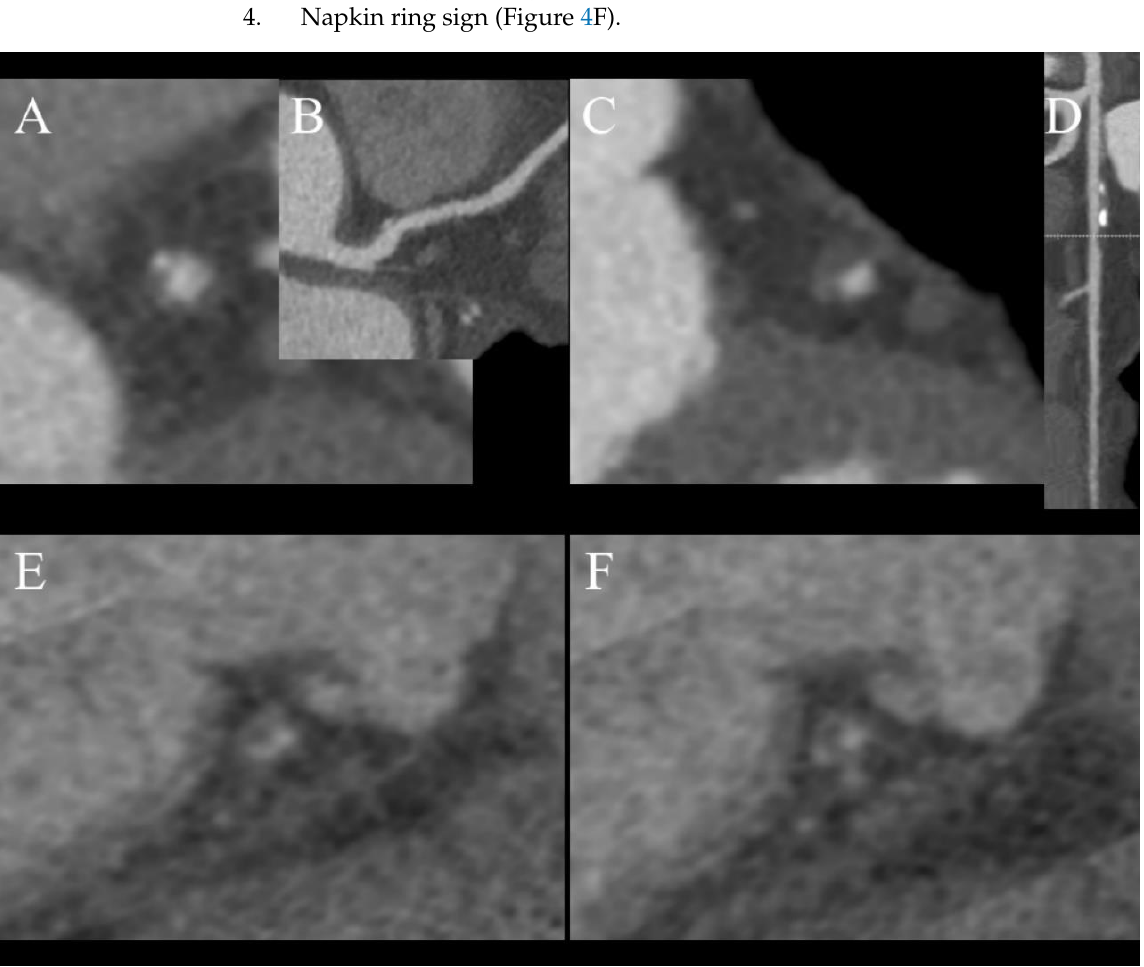
Figure 4. Features of venerable plaques. ( A , B ) — spotty calcification — calcification smaller than 3 mm and less than 150% lumen diameter ( A ) — short axis view, ( B ) — curved MPR of the vessel; ( C , D ) — positive wall remodeling — outer diameter of involved section of the vessel at least 110% of non-involved part of vessel; ( E , F ) — both plaques are noncalcified and low density (<30 HU) corresponding to cholesterol reach core, F — napkin ring sign — hyperdense outer part of noncalcified plaque.